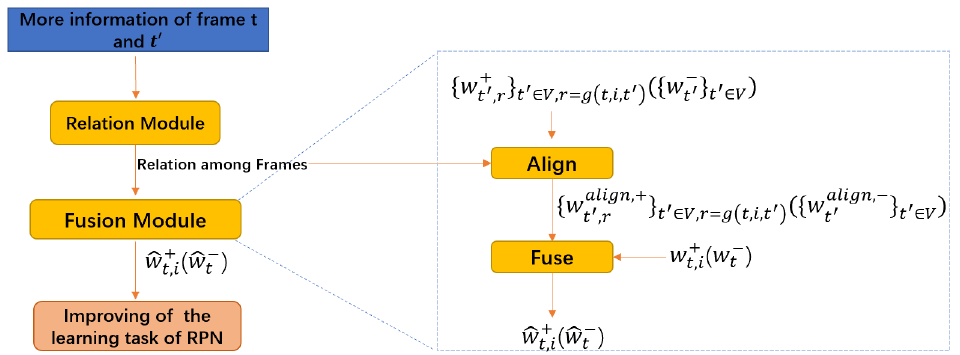
Figure 3. Temporal-guided label assignment framework. ’More information’ can be anything that comes from different frames. The fused (cid:98) w + network